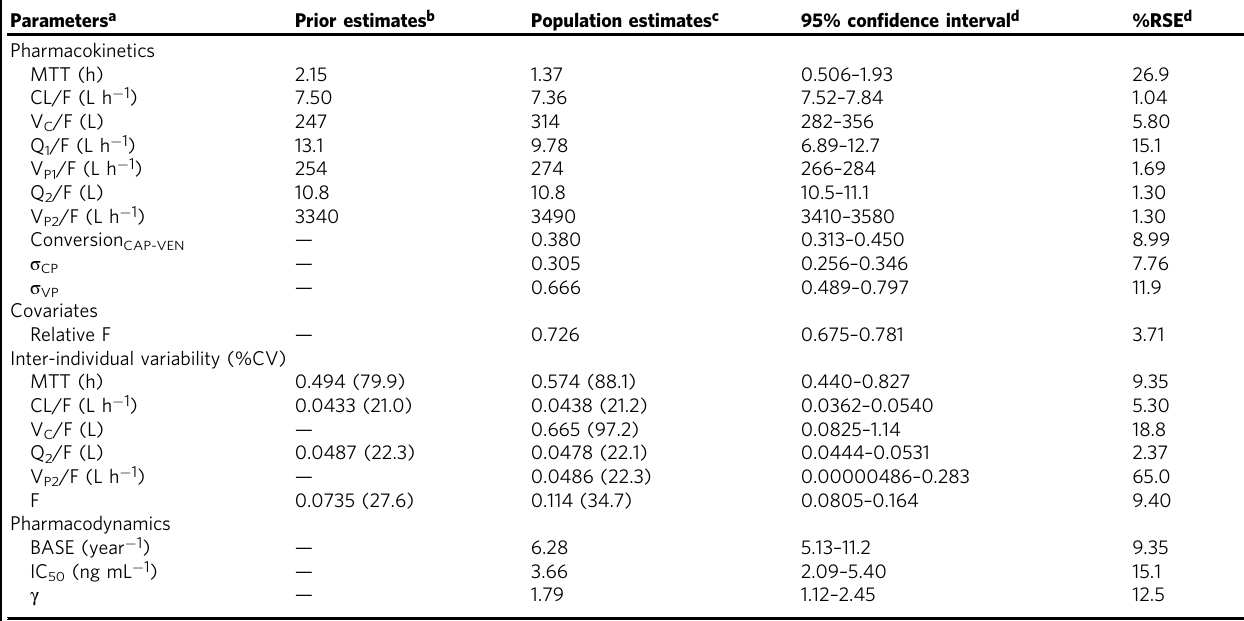
Table 2 Parameter estimates from the fi nal pharmacokinetic – pharmacodynamic model of piperaquine in children receiving seasonal malaria chemoprevention in Burkina Faso Parameters